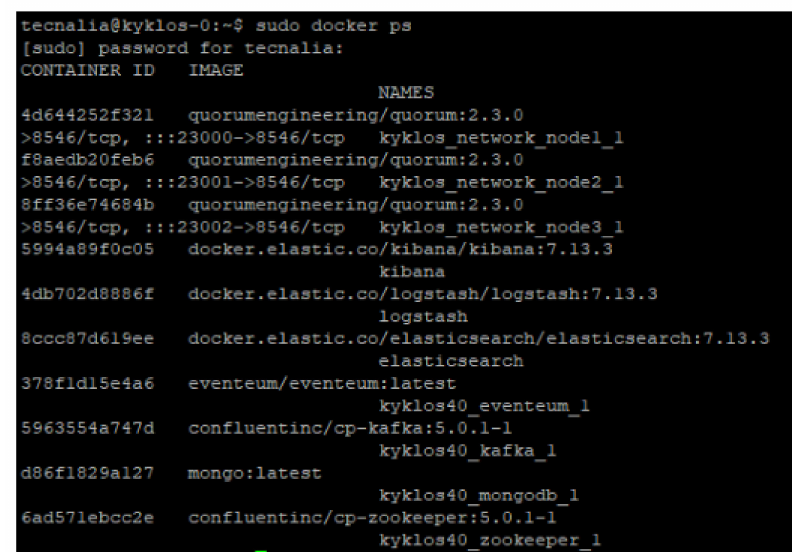
Figure 7. Docker images deployed in the validation experiment.